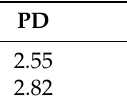
Figure 3. GPC chromatograms of comb-like-PC ( a ) and crosslinked-PC ( b ). Table 2. The molecular weight and distribution of PCs.